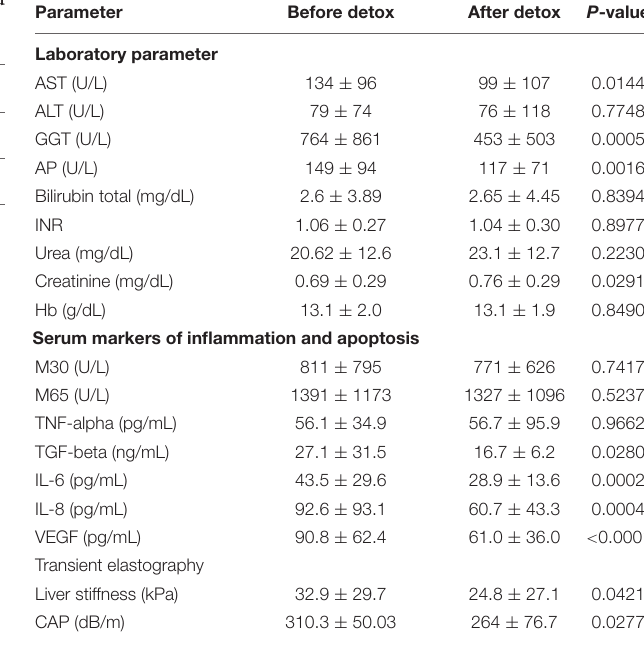
TABLE 3 | Laboratory and elastography parameters before and after alcohol detoxification ( n =